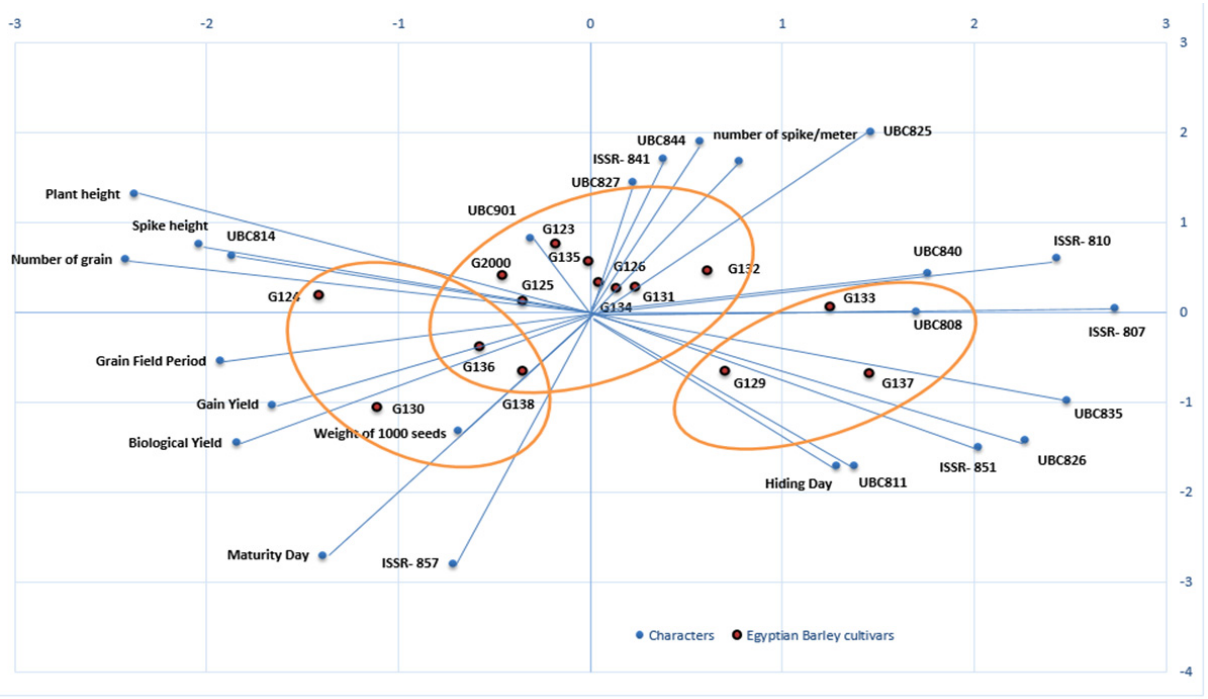
Figure 8. A biplot cluster tree illustrates the genetic distance between 15 Egyptian six-rowed barley cultivars, based on the analysis of 10 morpho-agronomic traits and 15 ISSR primers according to Euclidean distance and the UPGMA algorithm in PAST software.